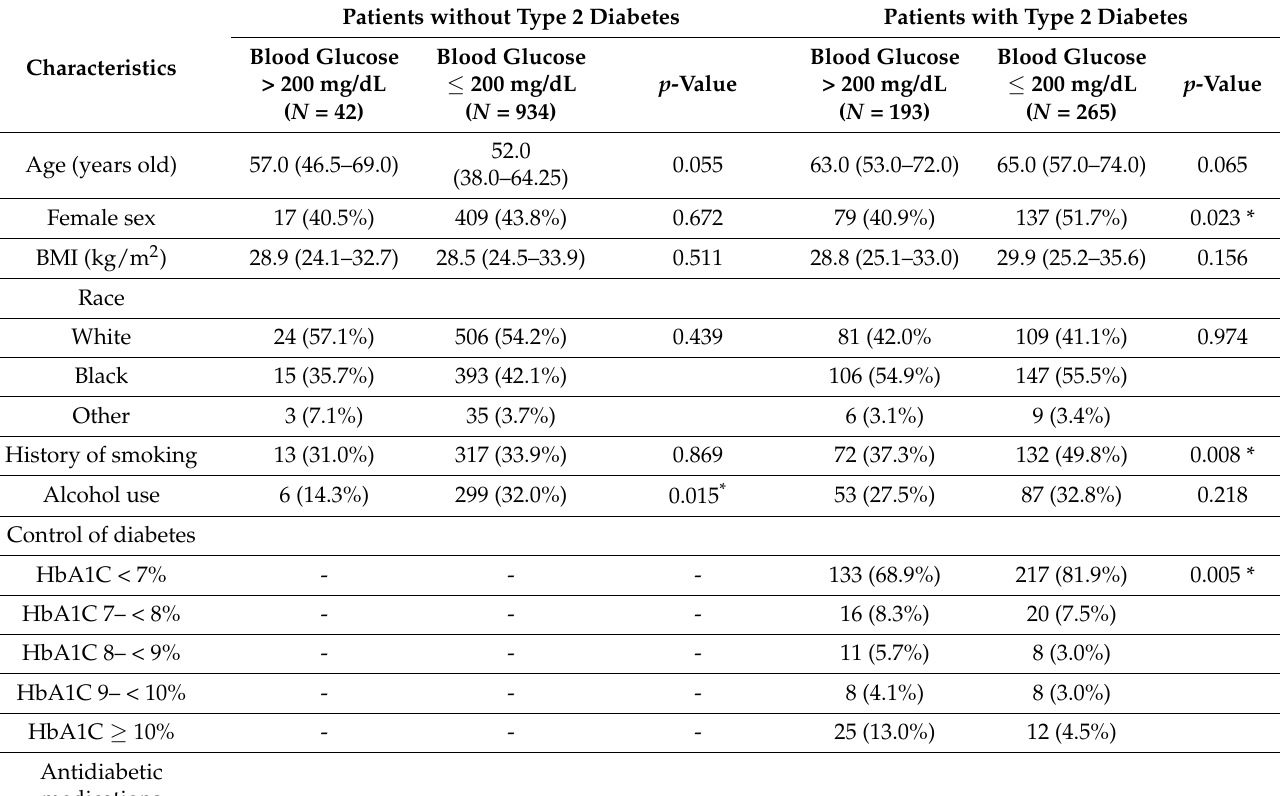
Table 1. Characteristics of patients with and without type 2 diabetes who had blood glucose >200 mg/dL and ≤ 200 mg/dL at hospital